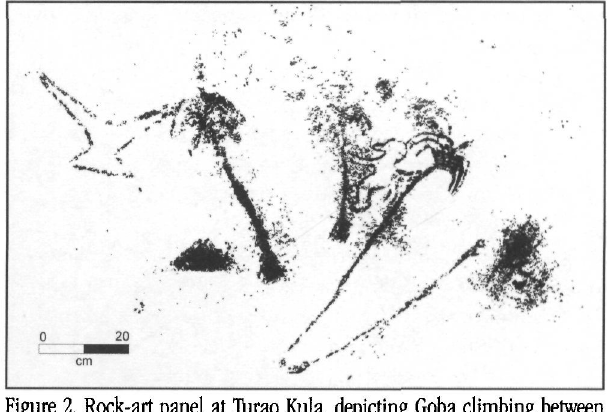
Figure 2. Rock-art panel at lurao Kula, depicting Goba climbing between two